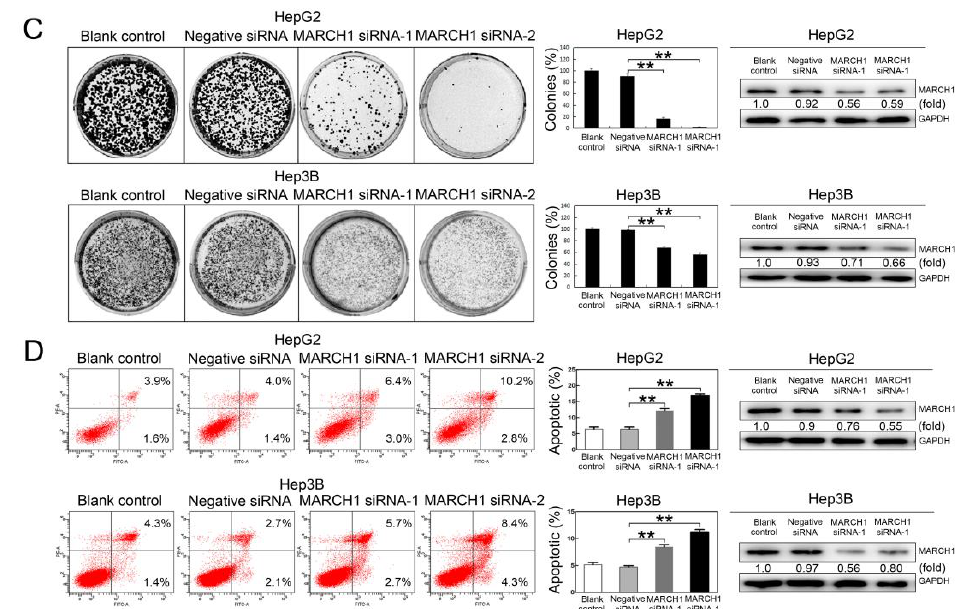
Figure 2. Effect of SAF on HCC cell apoptosis. ( A ) Colonies were stained with crystal violet solution as described in the Materials and Methods. Colony formation analysis of HepG2 and Hep3B cells treated with 0, 1.25, 2.5, and 5.0 µ M SAF for 24 h and 48 h, 0 µ M as control. ( B ) Flow cytometric analysis of apoptosis in HepG2 and Hep3B cells treated with 0, 1.25, 2.5, and 5.0 µ M SAF for 24 h and 48 h. The quantification of apoptotic cells was determined, 0 µ M as control. ( C ) Colony formation analysis of HepG2 and Hep3B cells treated with two sets of MARCH1 siRNA, negative siRNA, and non transfected for 48 h, negative siRNA as control. Western blotting was used to confirm the MARCH1 siRNA knockdown in HepG2 and Hep3B cells. ( D ) Flow cytometry showed the apoptosis rate of HepG2 and Hep3B cells treated with MARCH1 siRNA, negative siRNA, and nontransfected for 48 h, negative siRNA as control. Western blotting was used to confirm the MARCH1 silencing efficiency in HepG2 and Hep3B cells. All data in this figure are presented as means ± SD. ** p < 0.01, * p < 0.05. These data represent three independent experiments.